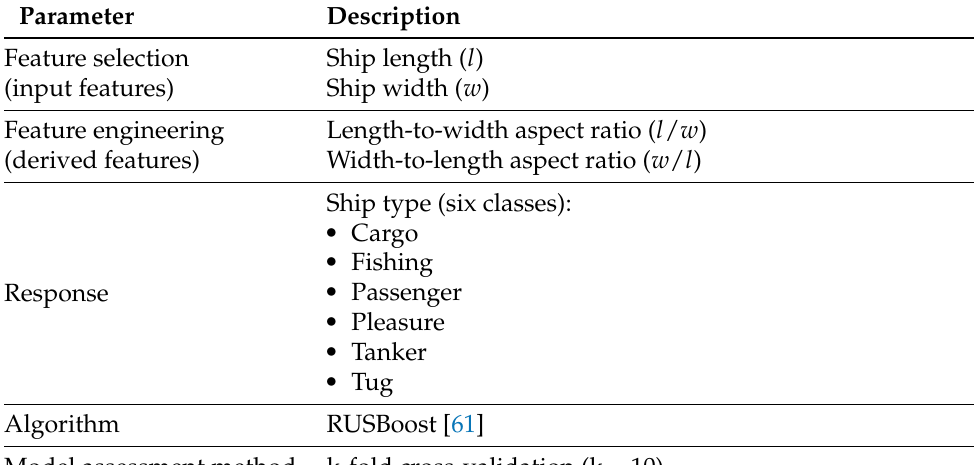
Table 2. Ship classification model